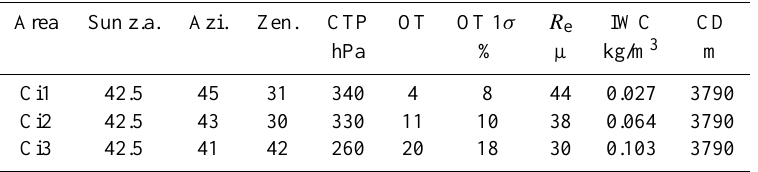
Table 2. Relevant parameters and retrieved cloud properties for the three areas selected for the MODIS case studies (the name is defined in column one) over the cirrus cloud of Fig. 22. SUN z.a. is the solar zenith angle; Azi. and Zen. are the azimuth and zenith observation angles; CTP, OT and R e are the MODIS retrieved cloud top pressure, optical thickness and effective radius; OT 1 σ is estimated error on OT. IWC is cloud ice water content and CD is assumed cloud layer depth. Sun z.a.